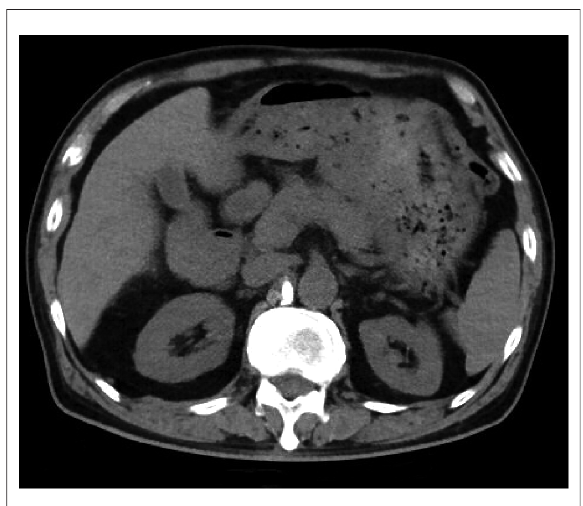
FIGURE 5 Abdominal CT showed no signs of pancreatitis and bone cement remained inside the diaphragm at 6 months of